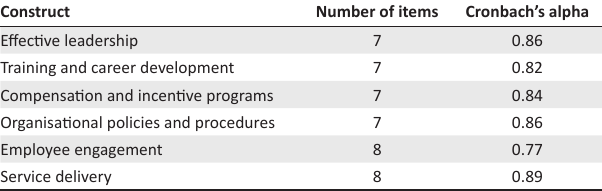
TABLE 3: Cronbach’s alpha reliability test. Construct